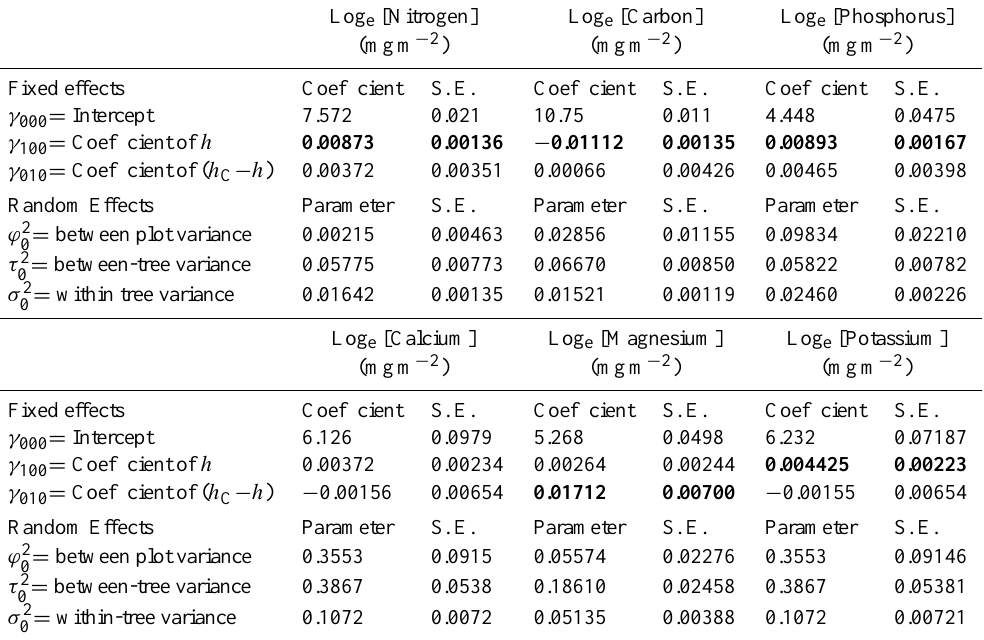
Table 2. Estimated intercept and coefficients according to Eq. (14) for leaf [N], leaf [C], leaf [P], leaf [Ca], leaf [Mg] and leaf [K], all expressed on a leaf area basis. Significant values (P ≤ 0.05) are shown in